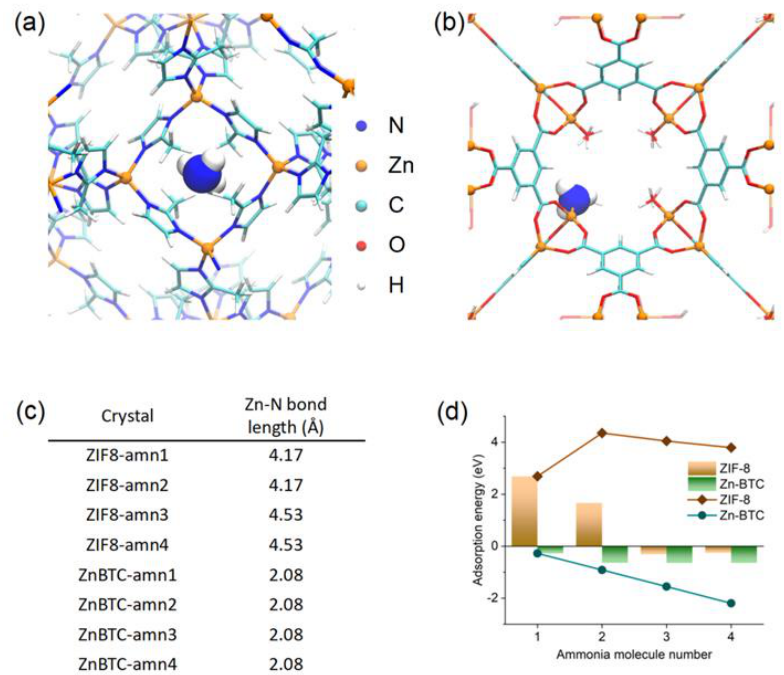
Figure 7. DFT calculation results of ammonia adsorption. ( a ) The structure of ZIF-8 with one adsorbed ammonia molecule (ZIF-8-amn1); ( b ) the structure of ZnBTC with one adsorbed ammonia molecule (ZnBTC-amn1), both of which were drawn by VMD (1.9.3) package [34]; ( c ) the Zn-N bond length in each adsorption structure; ( d ) the adsorption energy (column) and cumulative adsorption energy (line) of each crystal material.